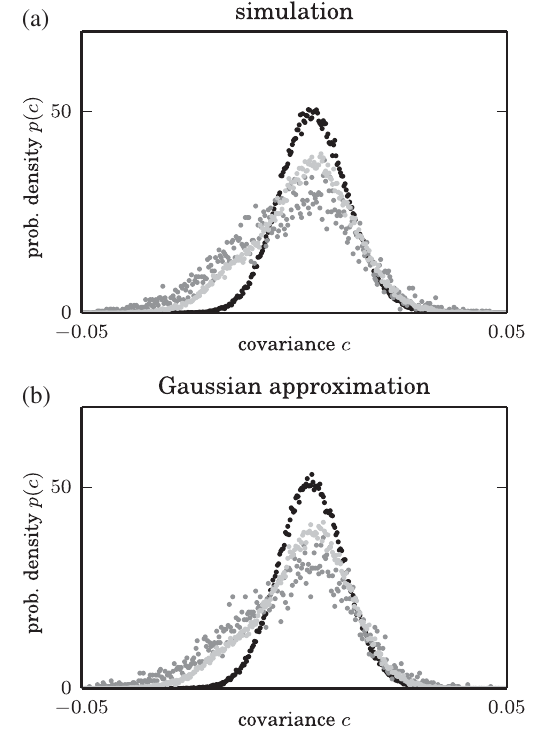
FIG. 2. Distribution of covariances in the Gaussian approxi- mation for a random network of binary neurons. (a) Distribution of cross-covariance between excitatory neurons (black) and inhibitory neurons (gray), and between one inhibitory and one excitatory neuron (light gray) from simulation. (b) Same as (a), but showing the theoretical result for the Gaussian approximation (15). Parameters are the same as in Fig. 1.